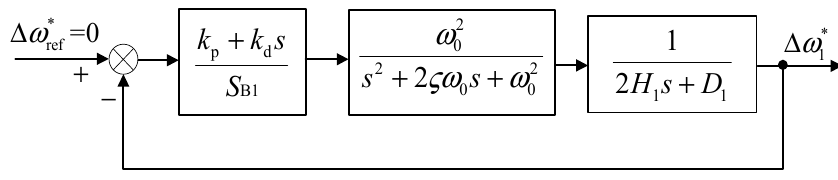
Figure 5. Diagram of UHVDC integrated system.